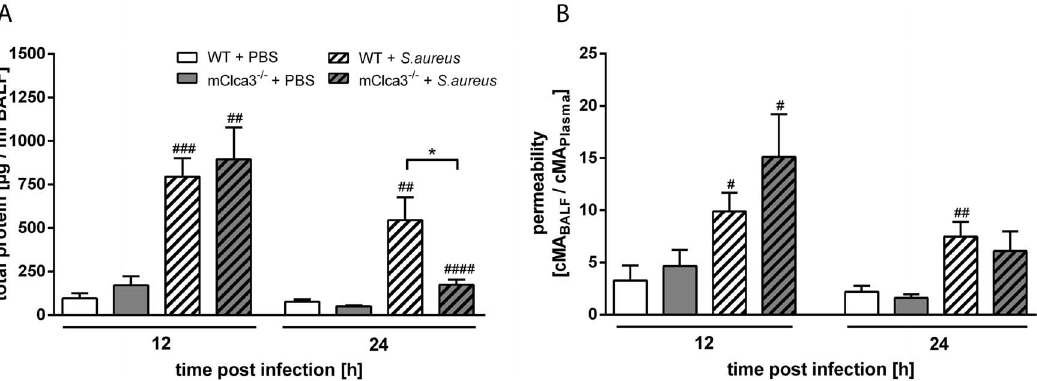
Figure 5. mCLCA3-deficiency led to reduced protein quantities in BALF during infection without altered pulmonary vascular permeability. (A) Total protein of BALF was examined at indicated time points by BCA-assay. (B) Mouse albumin (MA) of transnasally infected or uninfected mice was measured by ELISA in BALF and plasma. Pulmonary vascular permeability was calculated from the MA BALF/plasma ratio. Values are given as mean 6 SEM (n=8 each group). # p , 0.05, ## p , 0.01 versus the PBS control group. *p , 0.05 as indicated.